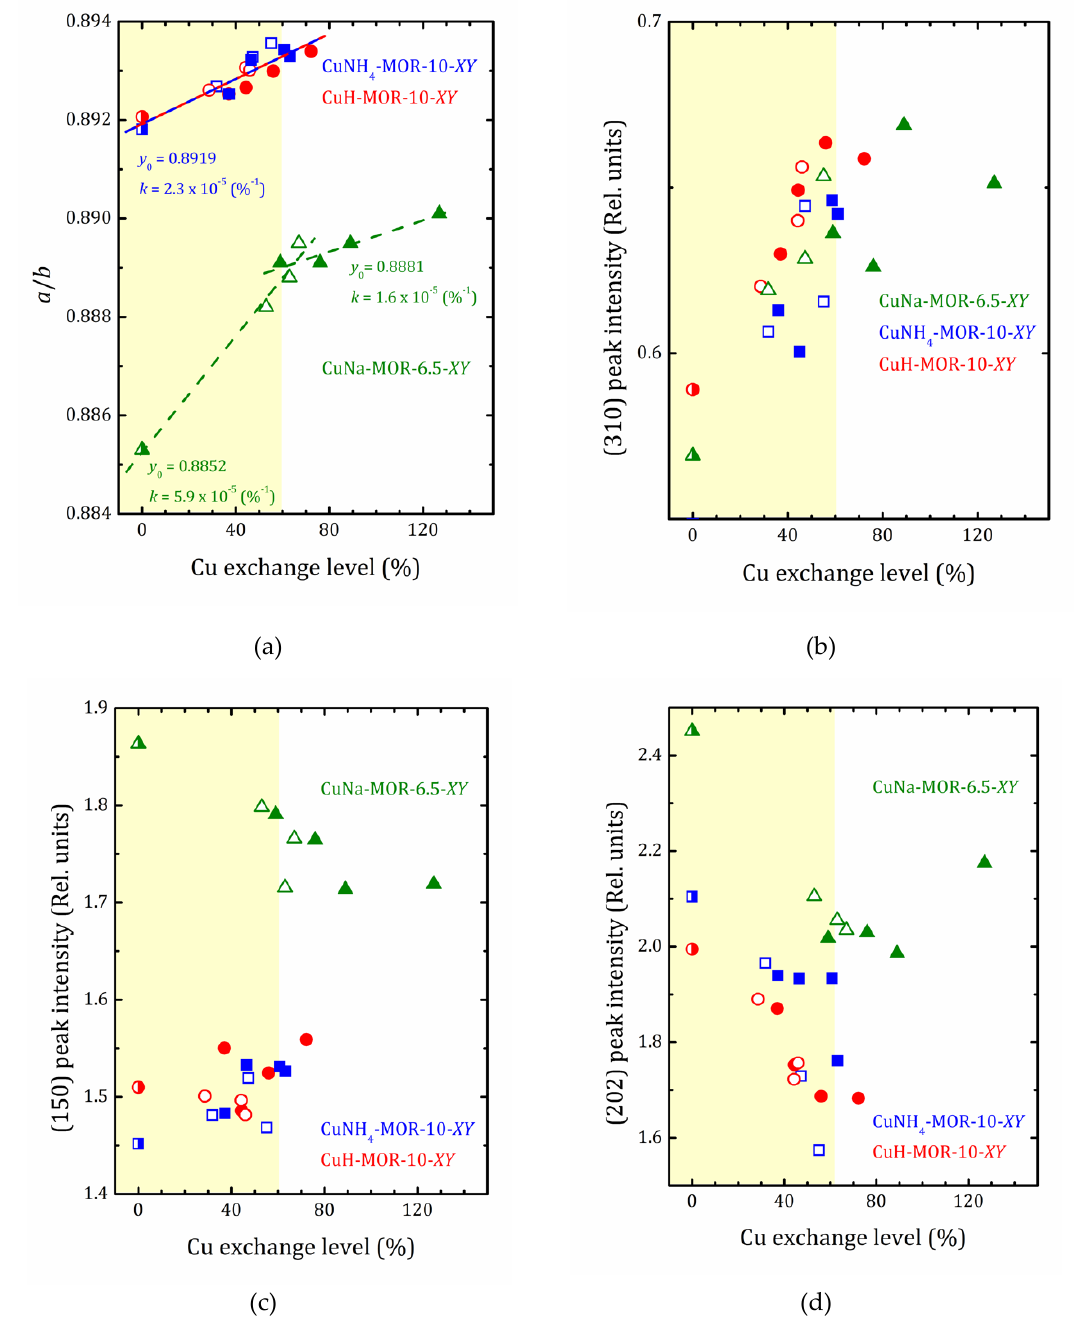
Figure 4. The a / b ratio ( a ) and normalized (310), (150), and (202) peak intensities (( b ), ( c ) and ( d ), respectively) versus copper-exchange level for the CuNH 4 -MOR-10- XY (squares), CuH-MOR-10- XY (circles) and CuNa-MOR-6.5- XY (triangles) series; open and closed symbols correspond to the conventional and MW-assisted treatment, respectively; semi-closed symbols correspond to the starting materials. Dashed lines show the linear fitting ( y = y 0 + kx ) of all the a / b data for CuNH 4 -MOR-10- XY and CuH-MOR-10- XY together; for CuNa-MOR-6.5- XY the data for the samples obtained by conventional and MW-assisted treatments are fitted separately; corresponding fitting parameters y 0 and k are given. The data for CuNa-MOR-6.5- XY are taken from [29] (adapted with permission from Ref. [29] Copyright 2017 Elsevier Inc.).